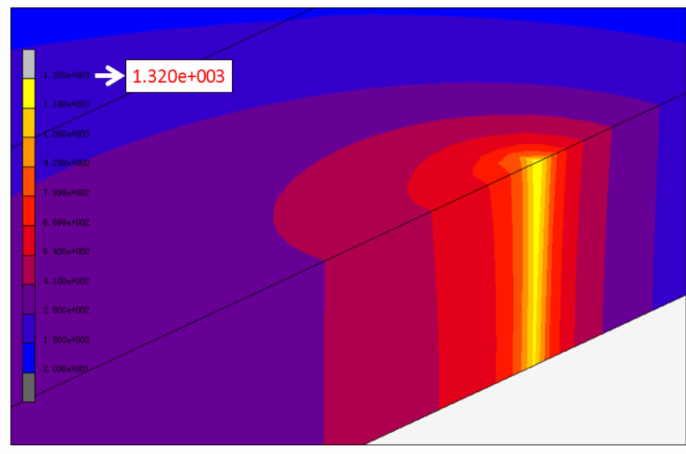
Figure 10. Temperature field distribution of 7055 alloy joint by electron beam welding